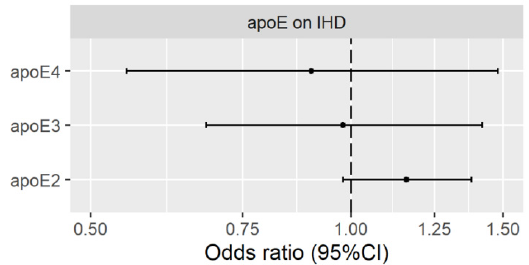
Figure 2. Multivariable MR estimates for plasma apolipoprotein E2 (apoE2), apolipoprotein E3 (apoE3) and apolipoprotein E4 (apoE4) on ischemic heart disease (IHD) using inverse variance weighting with genetic predictors from the KORA study.